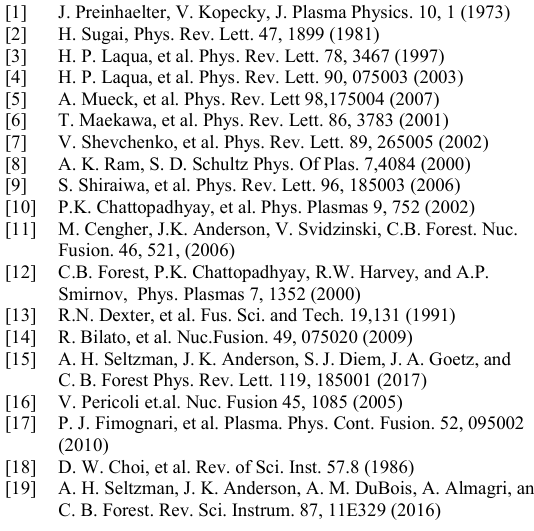
Fig 9. Net vs forward RF power for X-mode (blue) and O- mode(red) launches over a range of plasma currents corresponding to 1 st -11 th harmonic absorption. Boundaries between harmonics are demoted with vertical red